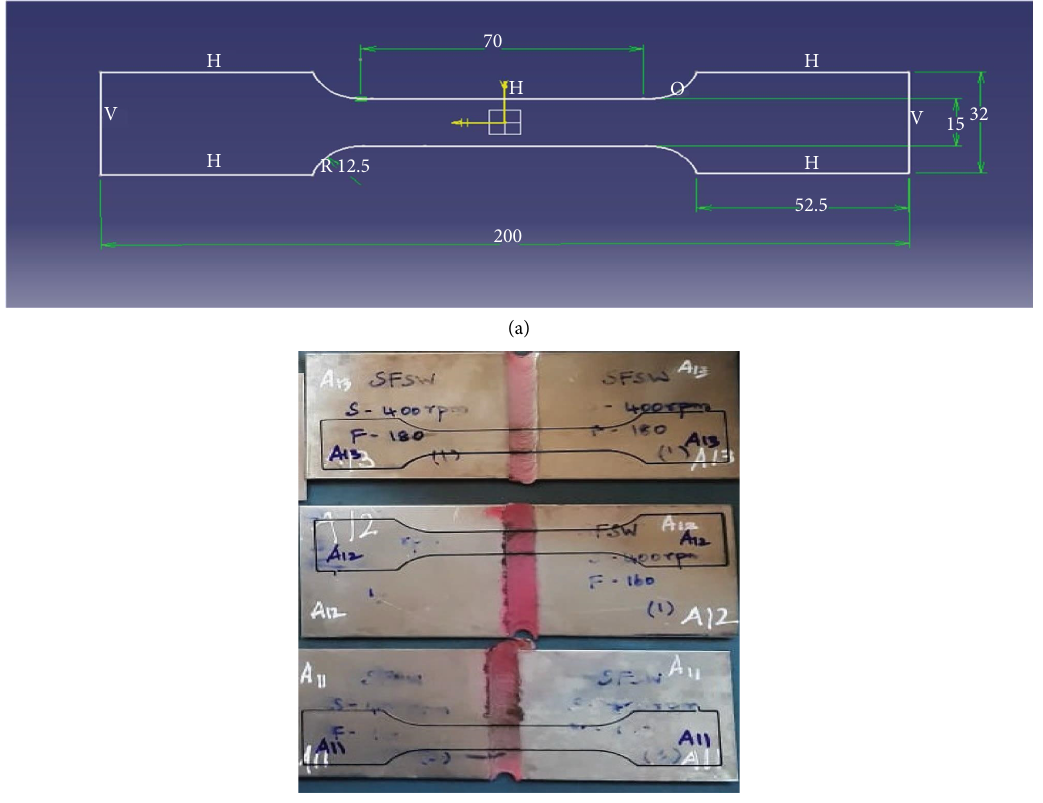
Figure 1: (a) Dimensions of the tensile specimen; (b) tensile specimens cut from the welded joints.